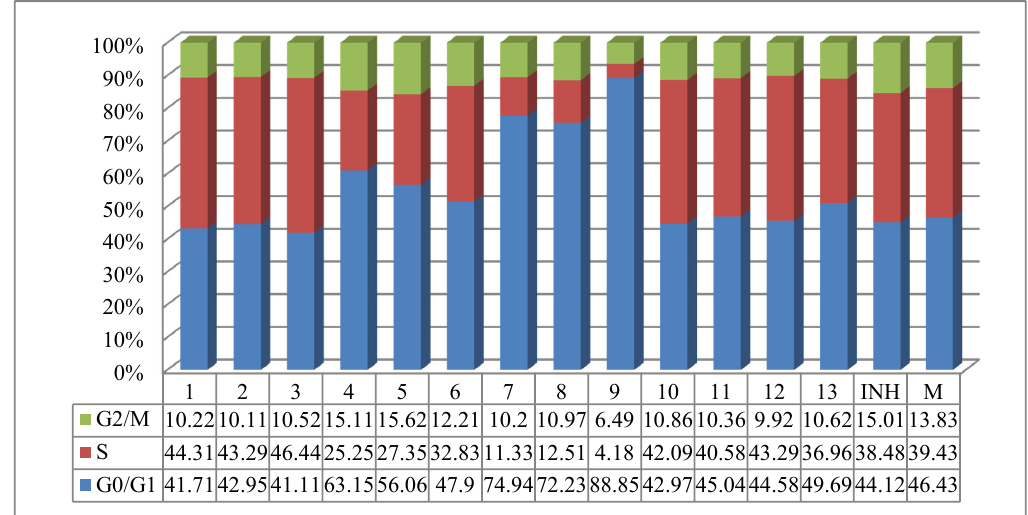
Figure 5. The influence of the new isoniazid derivatives on cell cycle in eukaryotic cells after a 24 h treatment.